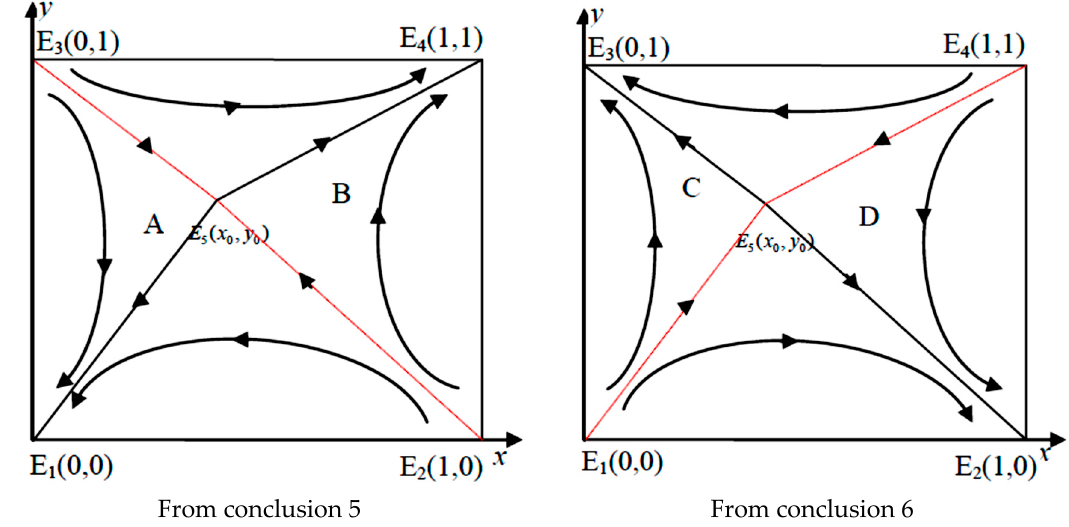
Figure 1 The dynamic phase diagram of system evolution under conclusion 5 and conclusion 6.